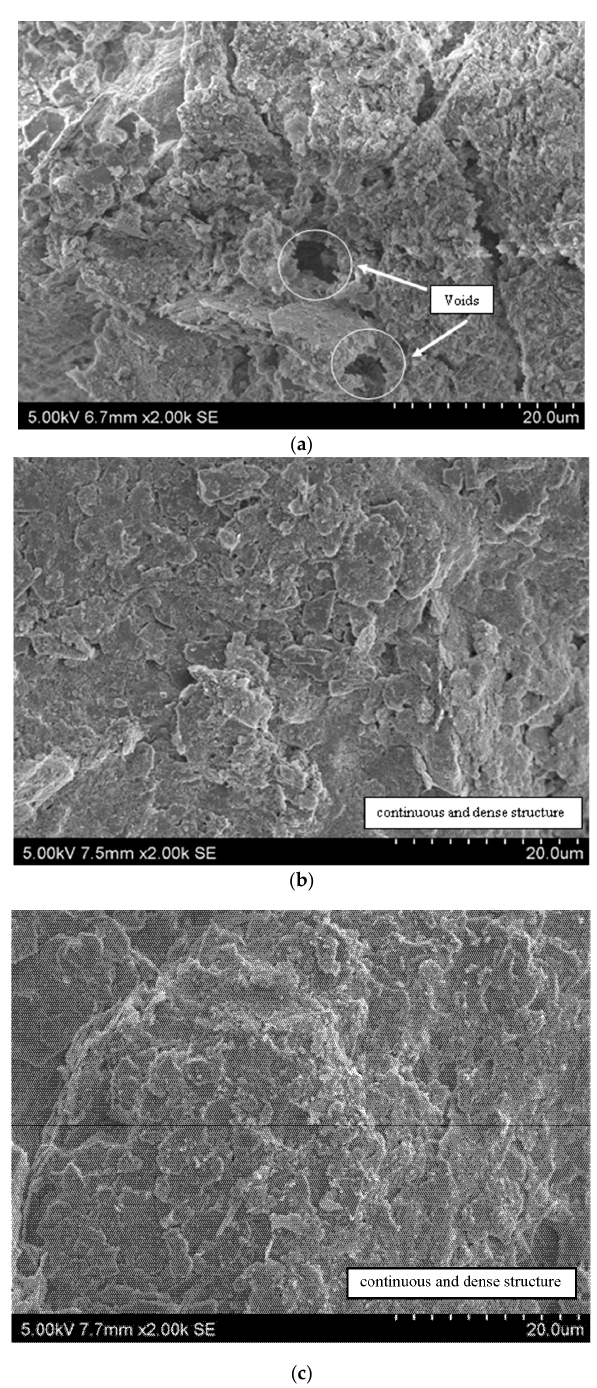
Figure 6. Variable-pressure scanning electron microscope (VP-SEM) images for untreated and nanoparticles-treated residual soils. ( a ) Natural soil (NS); ( b ) calcium hydroxide treated soil (CS); ( c ) Magnesium hydroxide treated soil (MS).